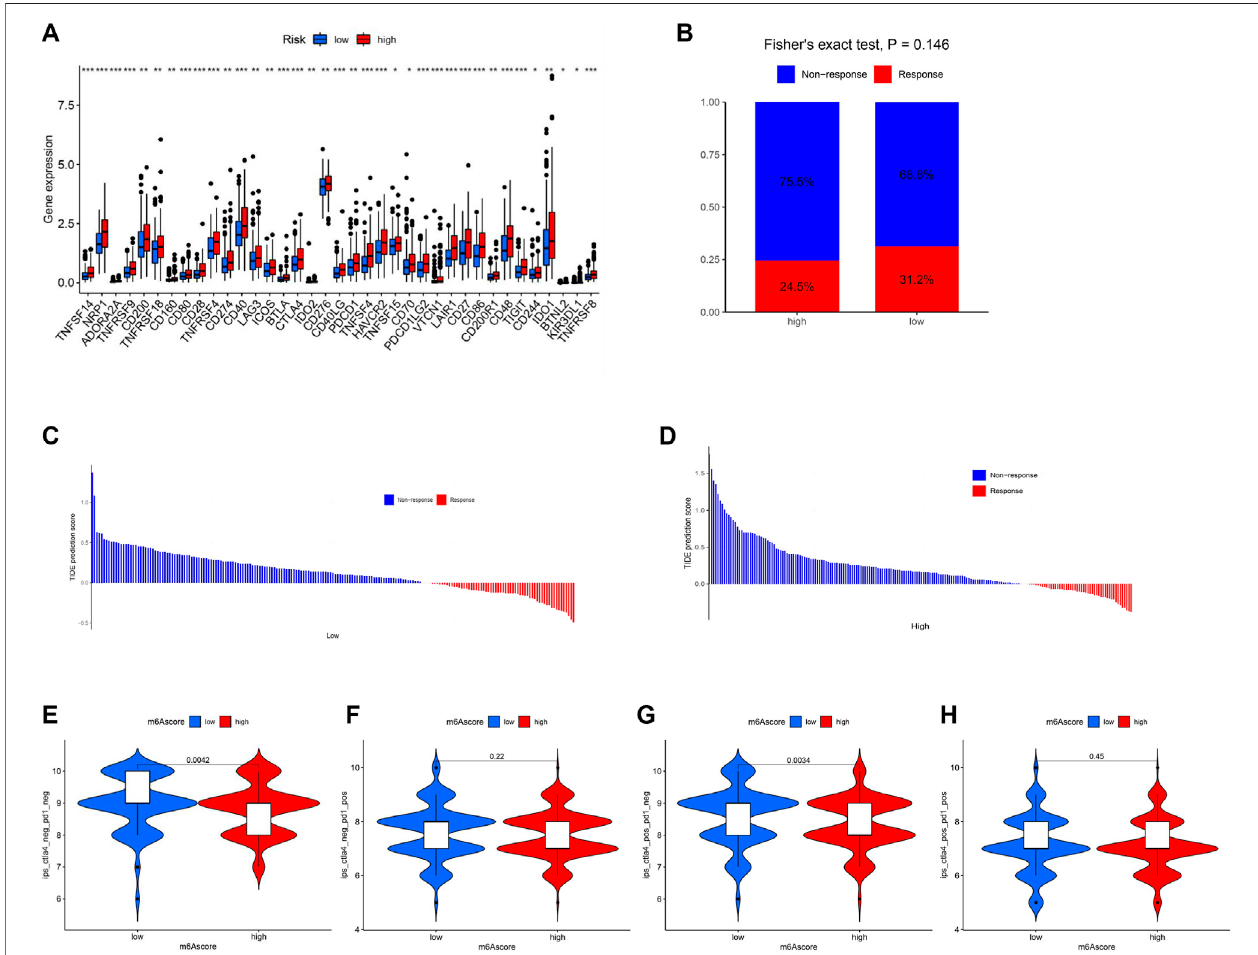
FIGURE 6 | Prediction of immunotherapeutic treatment. (A) Expression of 37 immune checkpoint genes was signi fi cantly different between high- and low-risk patients. p < 0.05 (*), p < 0.01 (**), and p < 0.001 (***). (B) Box plot of the TIDE prediction scores of COAD patients. (C,D) Waterfall plot of the TIDE prediction scores of COAD patients. (E – H) Immunophenoscore of the high- and low-risk groups from TCIA.